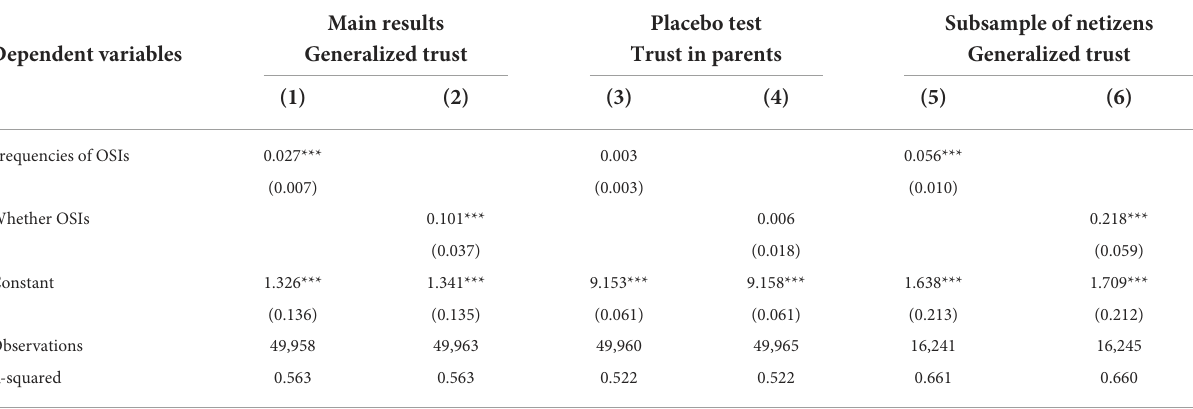
TABLE 1 The effects of OSIs on generalized trust.